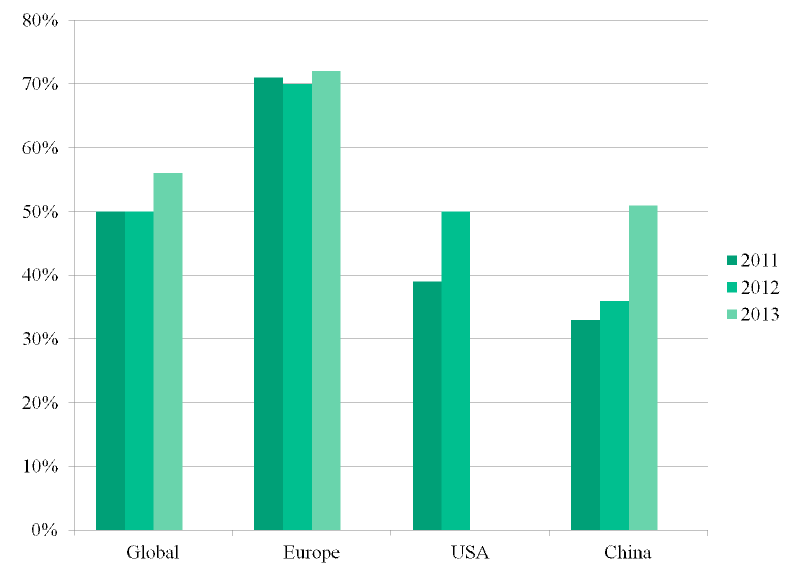
Figure 9. Green power as share of new power capacity, 2011–2013